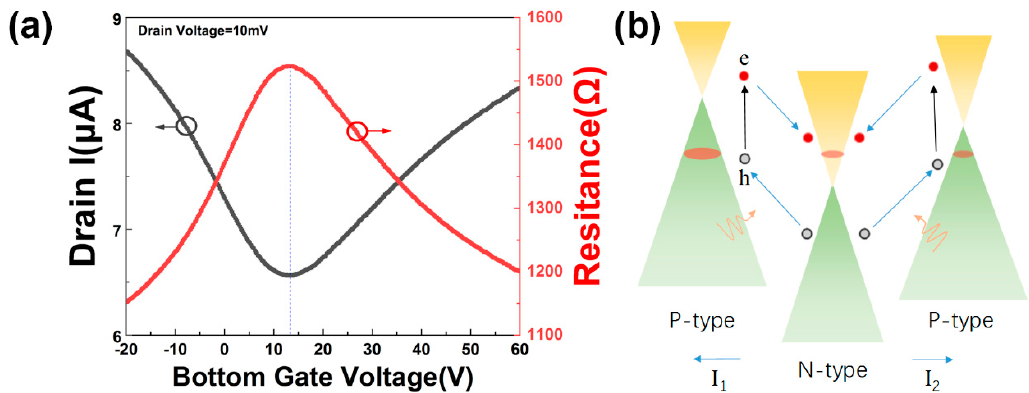
Figure 4. ( a ) Transfer characteristic curve of bottom gate graphene FET(field effect transistor) on Si/SiO 2 substrate. The monolayer graphene transferred on the Si/SiO 2 exhibits p-type. ( b ) Band structure of the horizontal p-n-p junction, blue arrows describe the movement of photo-induced electrons (red balls) and holes (gray balls).